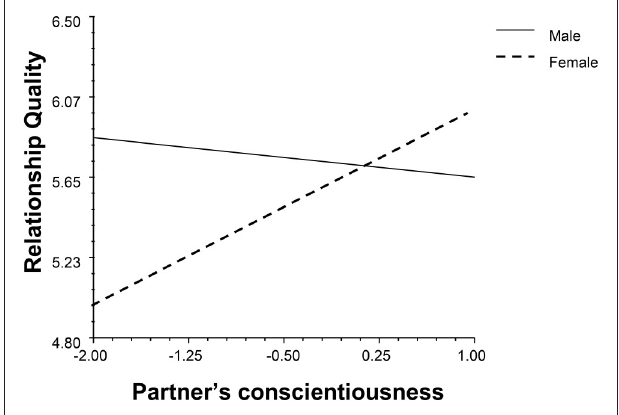
FIGURE 3 | The interaction between partner’s conscientiousness and gender.